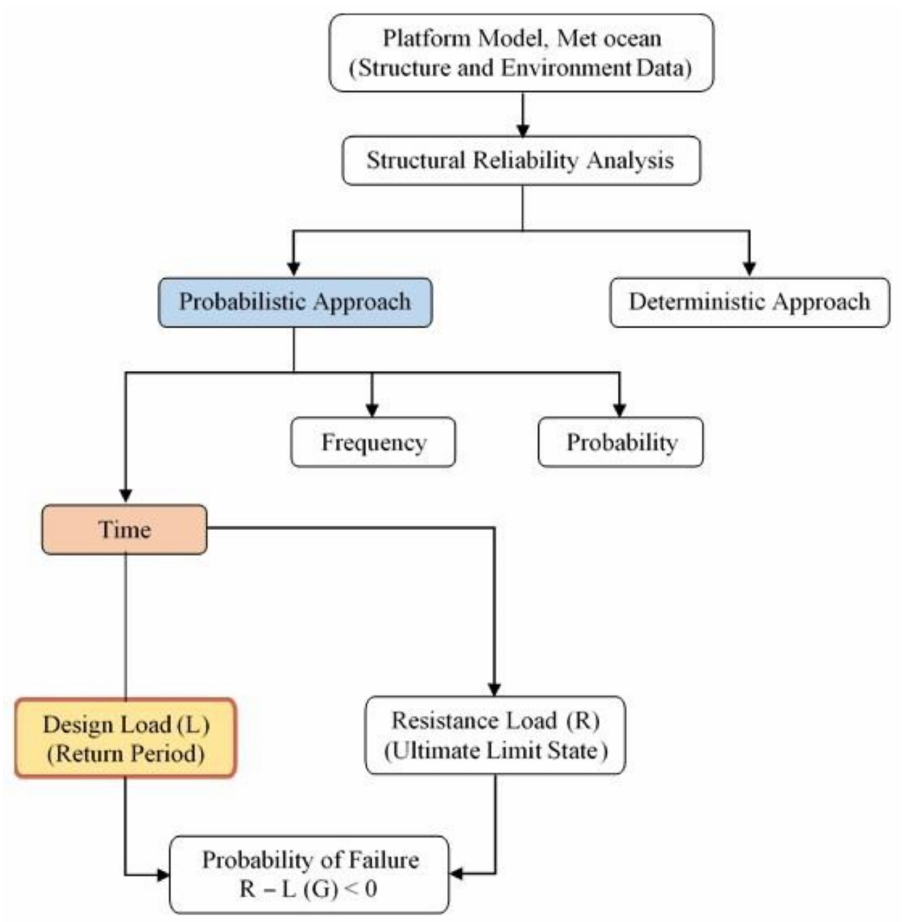
Figure 1. Determination of the probability of failure using the structural reliability analysis